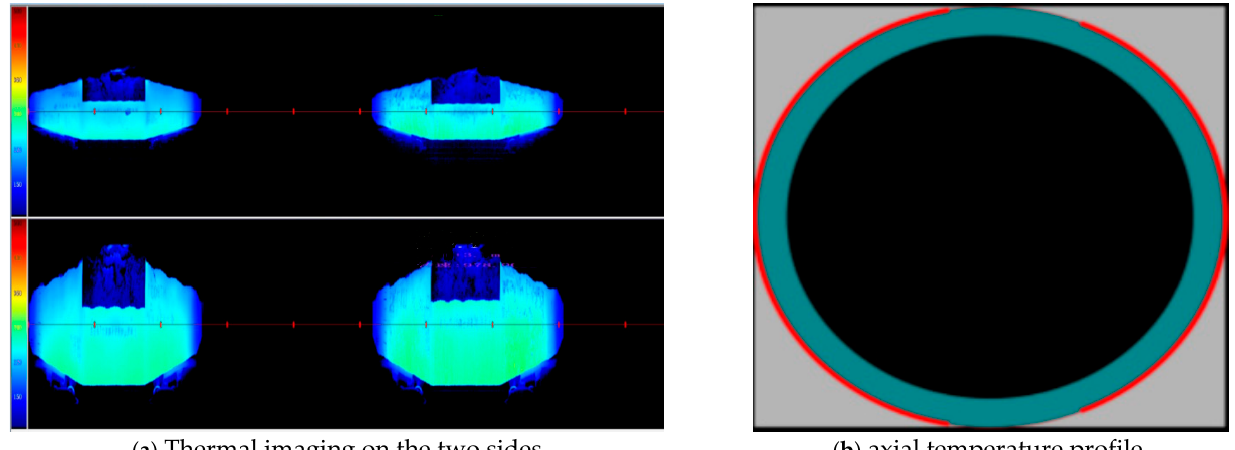
Figure 6. ( a ) Mechanical diagram of 320 t torpedo car, ( b ) thermal imaging.